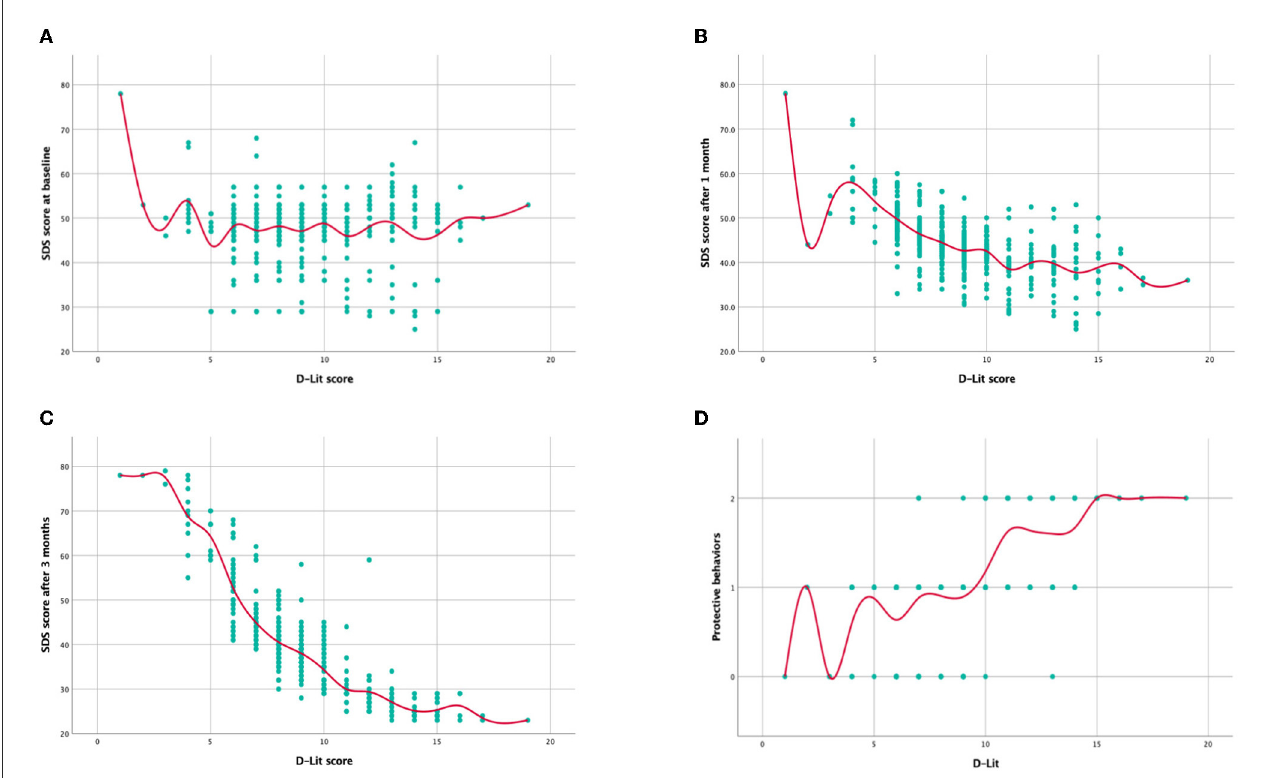
FIGURE1 The correlation between D-Lit and SDS at different time points, and protective behaviors of participants. (A) Correlation between D-Lit score and Zung SDS score at baseline (Spearman’s correlation test, statistical significance p = 0.344). (B) Correlation between D-Lit score and Zung SDS score after 1 month (Spearman’s correlation test, statistical significance p < 0.001). (C) Correlation between D-Lit score and Zung SDS score after 3 months (Spearman’s correlation test, statistical significance p < 0.001). (D) Correlation between D-Lit and protective behaviors of participants against depressive mood (Spearman’s correlation test, statistical significance p < 0.001). In the y-axis of picture D, 0 denotes “Never” 1 denotes “Sometimes” and 2 denotes “Always.” D-Lit, depression literacy; SDS, self-rating depression